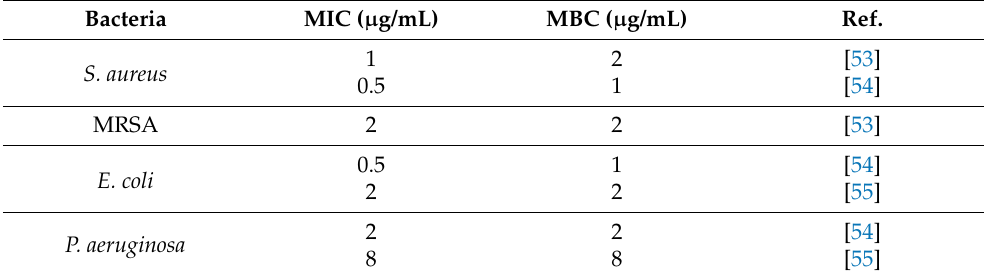
Table 1. Minimum inhibitory concentration (MIC) and minimum bactericidal concentration (MBC) values of polyhexanide (PHMB) against bacterial species relevant to infected